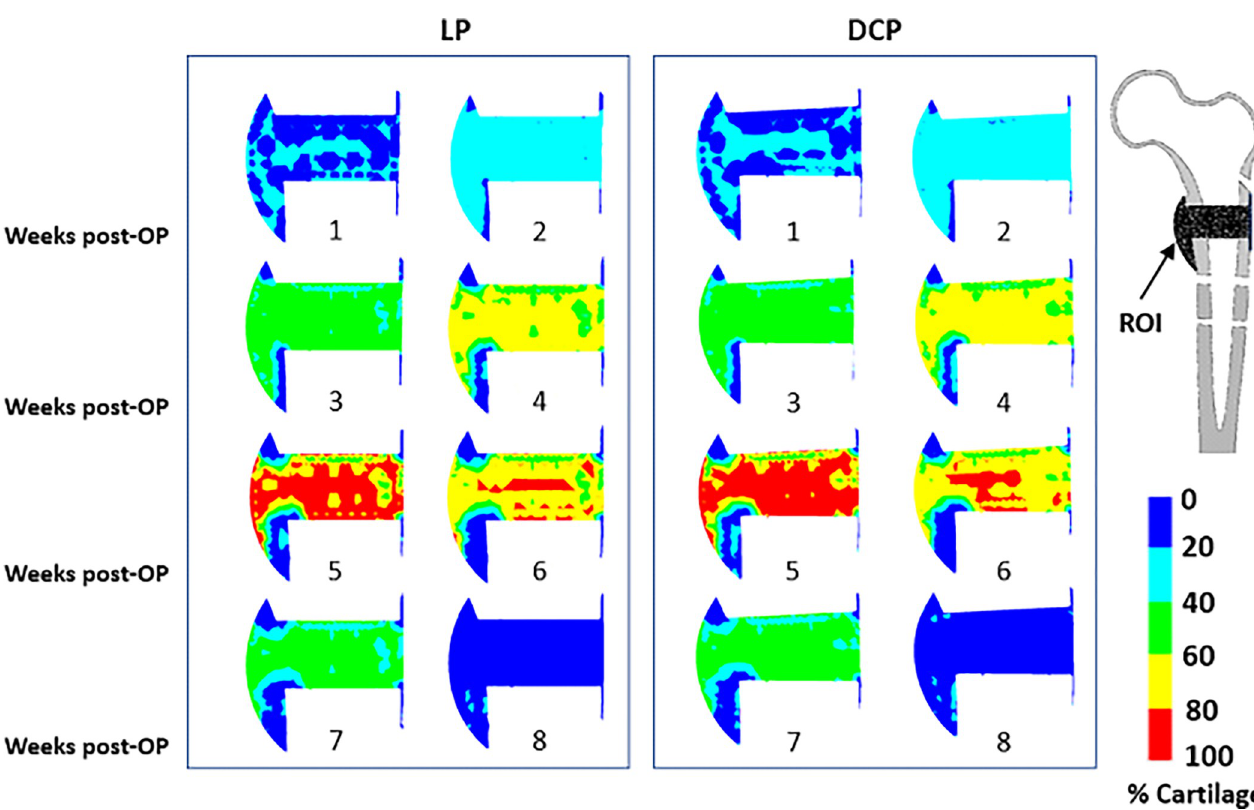
Fig 6. Post-operative distribution of percentage cartilage concentration in the ROI from week 1–8 for (a) LP and (b) DCP.